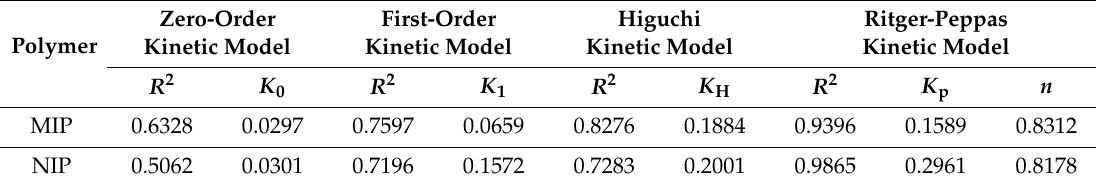
Table 7. Linear fitting of cumulative drug di ff usion